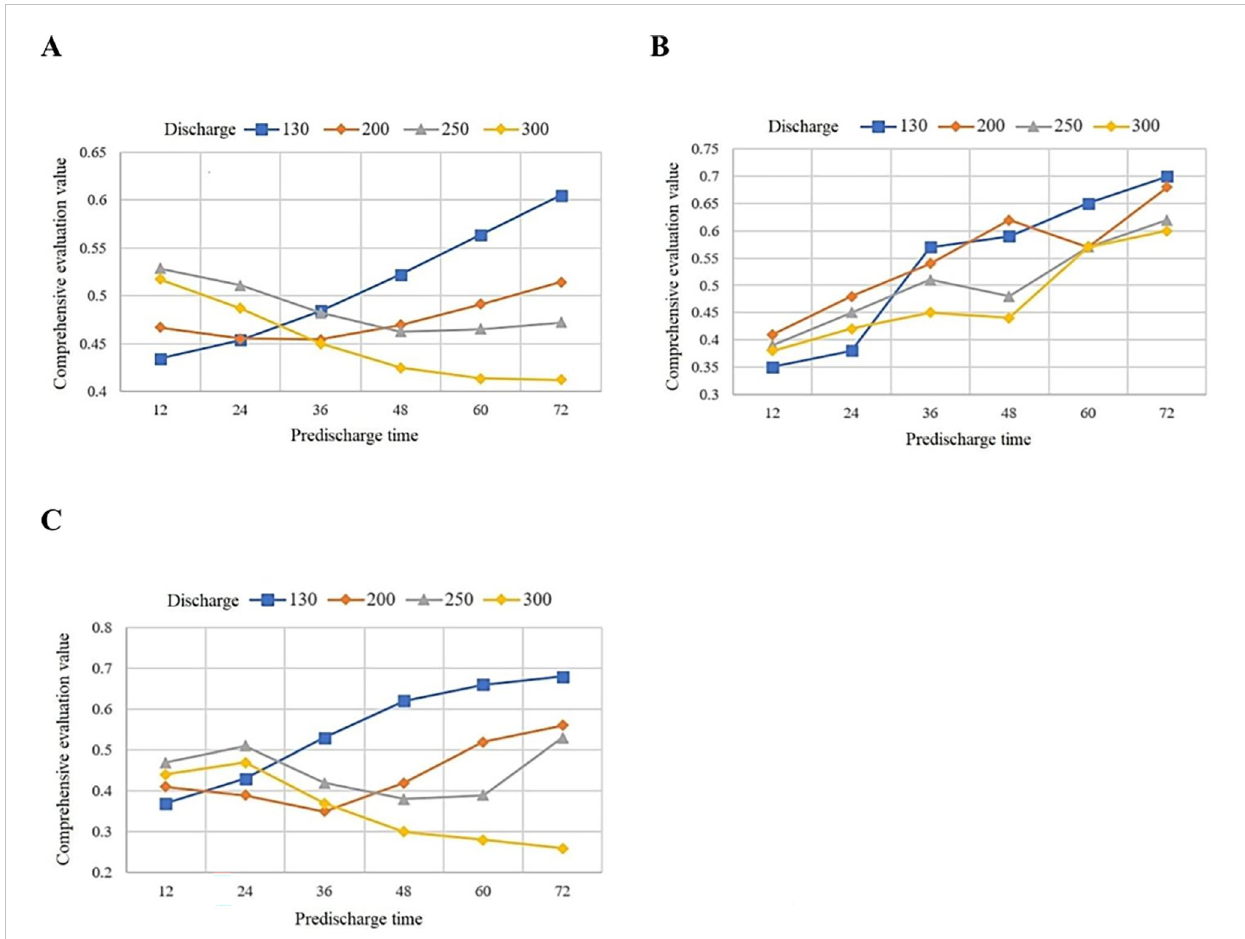
FIGURE 6 Comparison of different pre discharge schemes under different pre discharge time in dataset 1-3. (A) Dataset 1. (B) Dataset 2. (C) Dataset